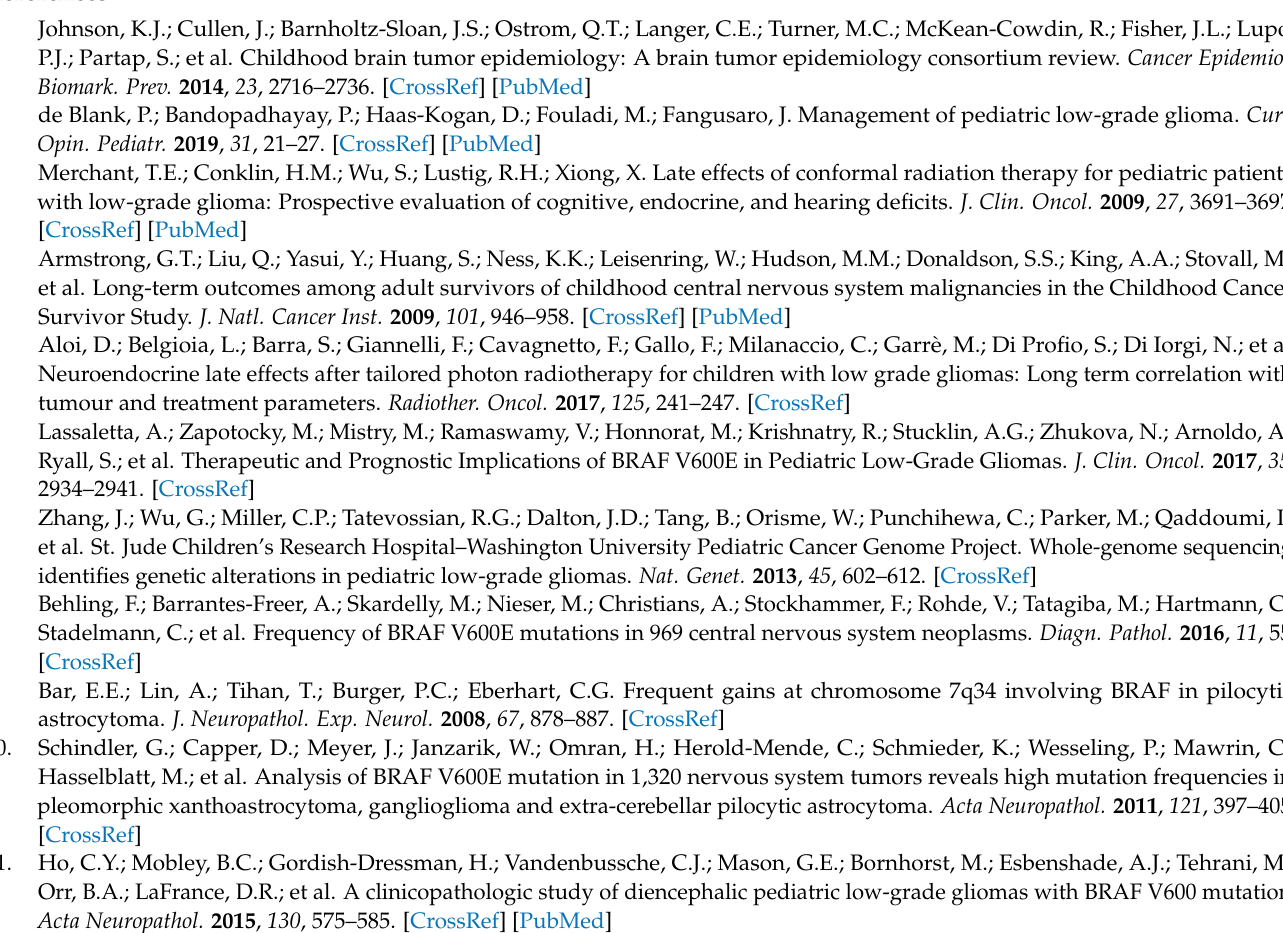
Supplementary Table S3: Fasting blood glucose, biochemical liver, and kidney-function tests before and during